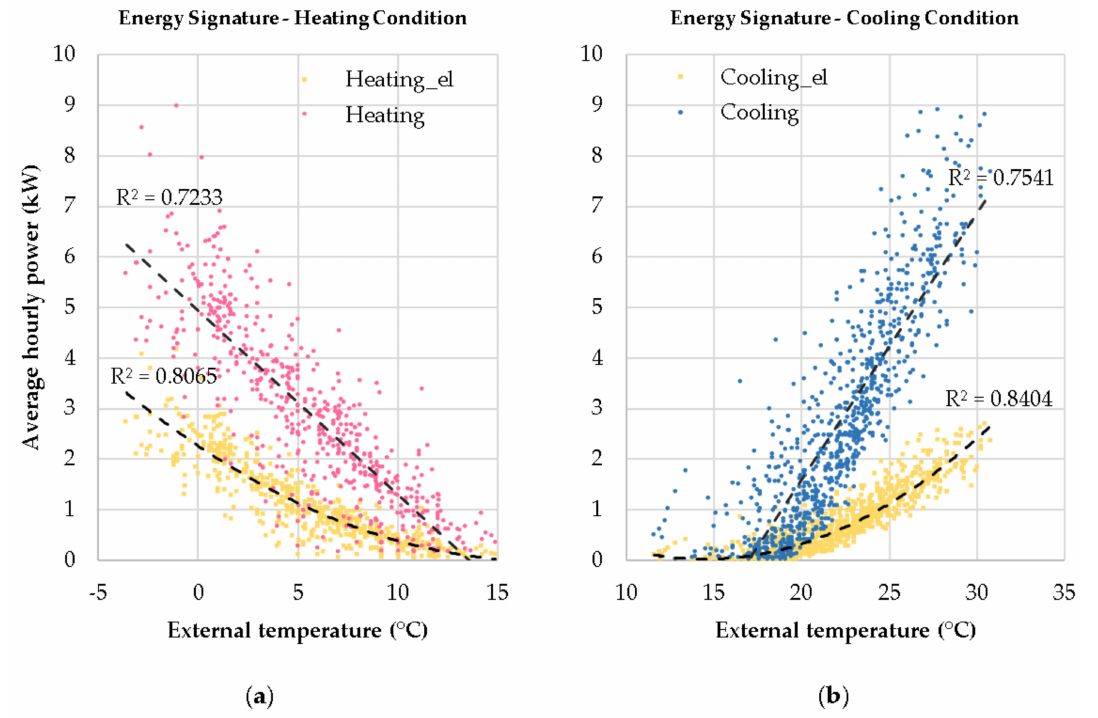
Figure 7. PVZEN facility energy signature in heating ( a ) and cooling ( b )